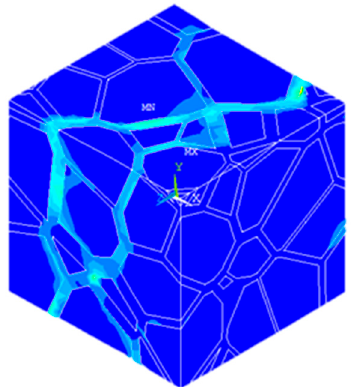
Figure 15. Illustration of strain distribution into representative volume element (RVE) subjected to uniaxial tensile loading.